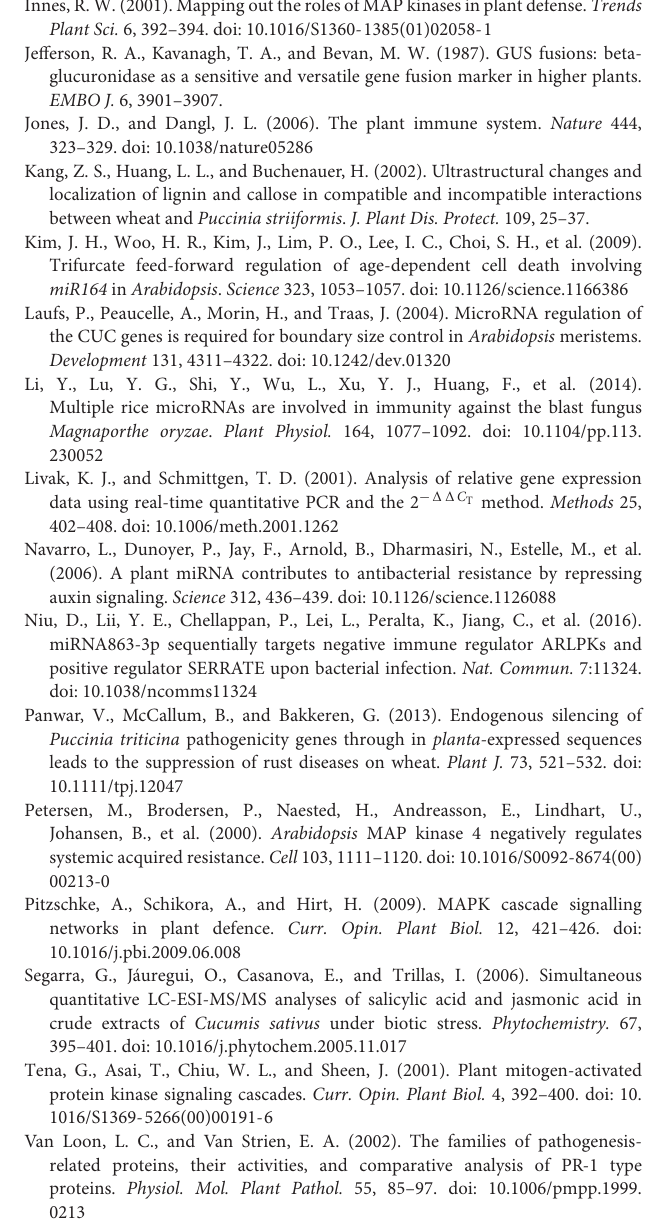
FIGURE S1 | Subcellular localization of the TaMAPK4 protein. GFP and TaMAPK4-GFP fusion proteins were expressed in wheat protoplasts. Bar = 20 µ m.